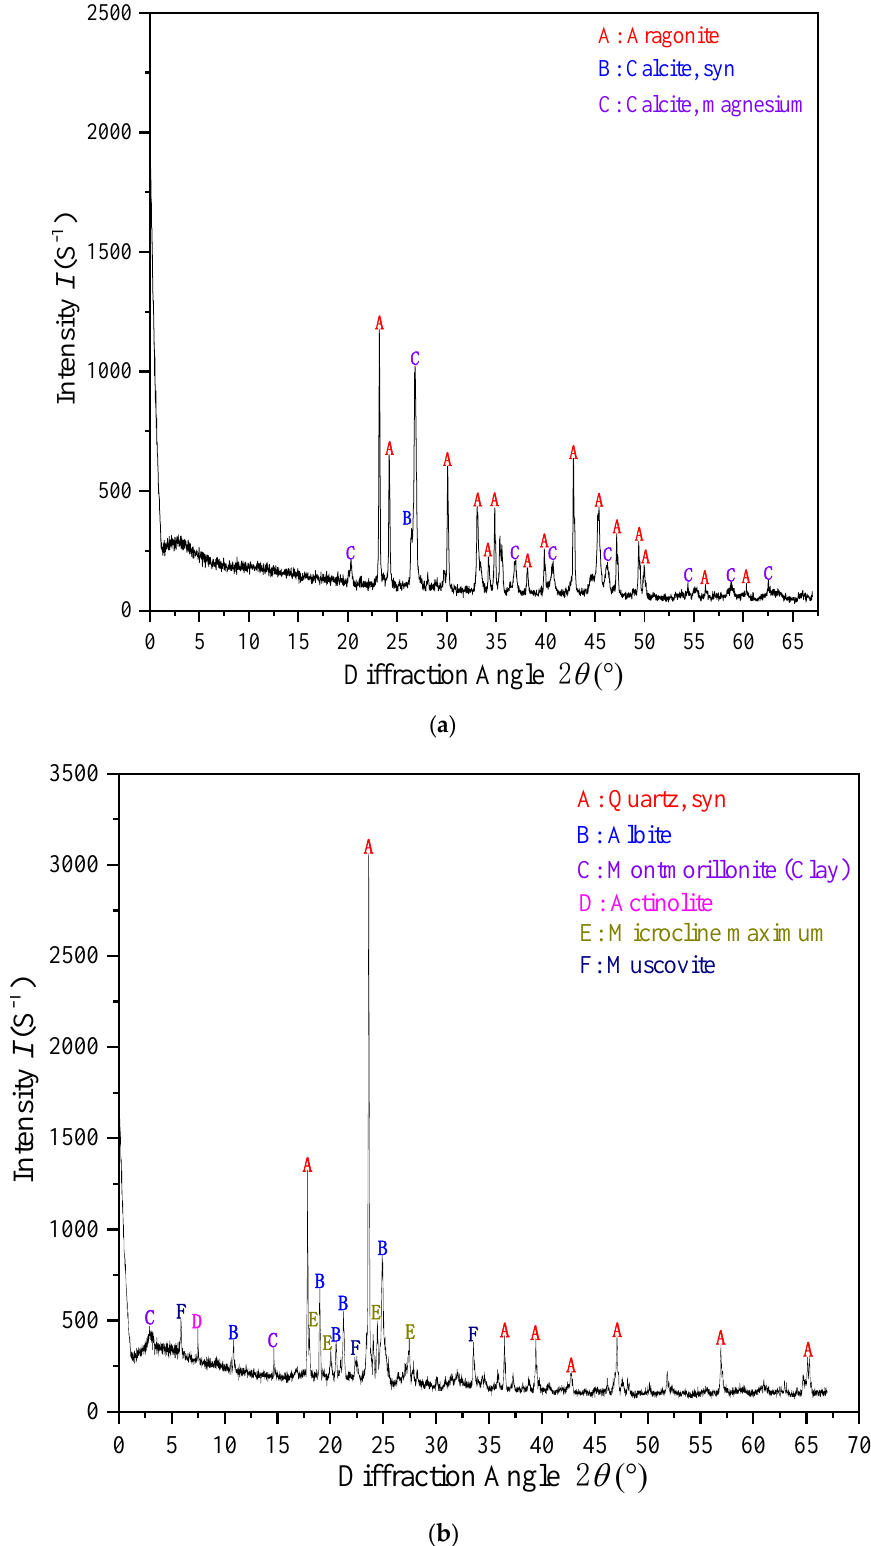
Figure 3. X-ray diffraction patterns of coral sand and quartz sand: ( a ) coral sand and ( b ) quartz